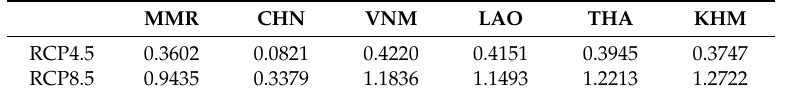
Table 2. Trends in the precipitation extremes